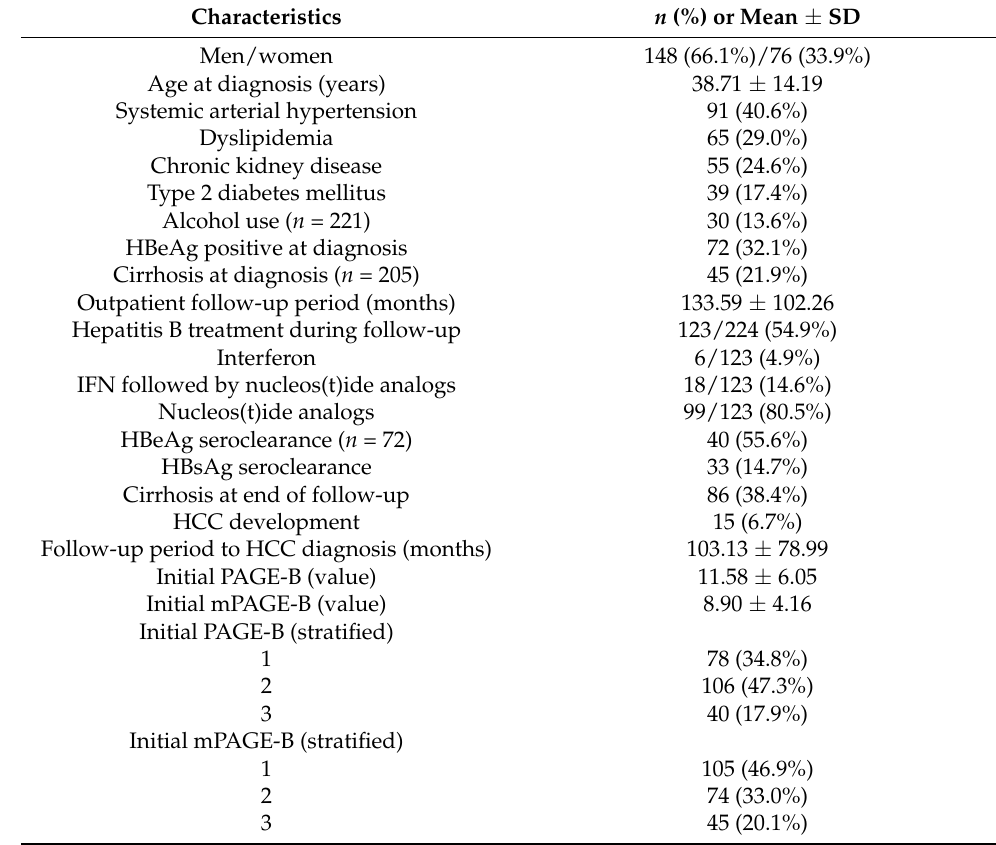
Table 1. Population characteristics ( n =